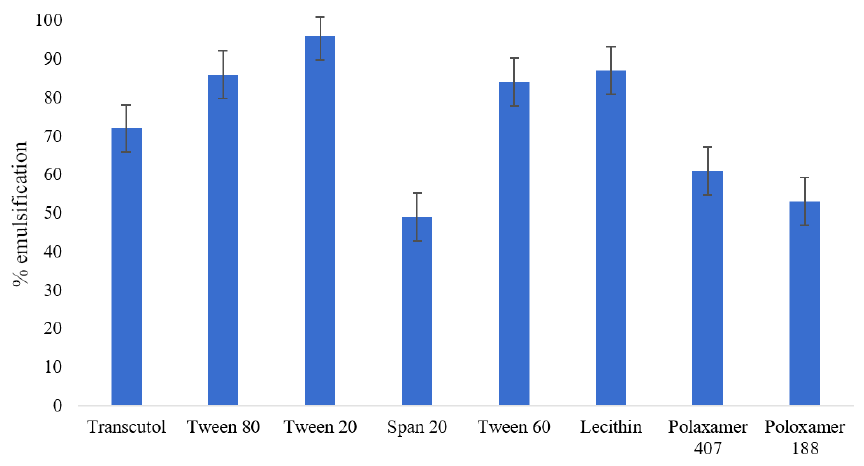
Figure 2. Comparative corn oil emulsification potential of various screened surfactants.